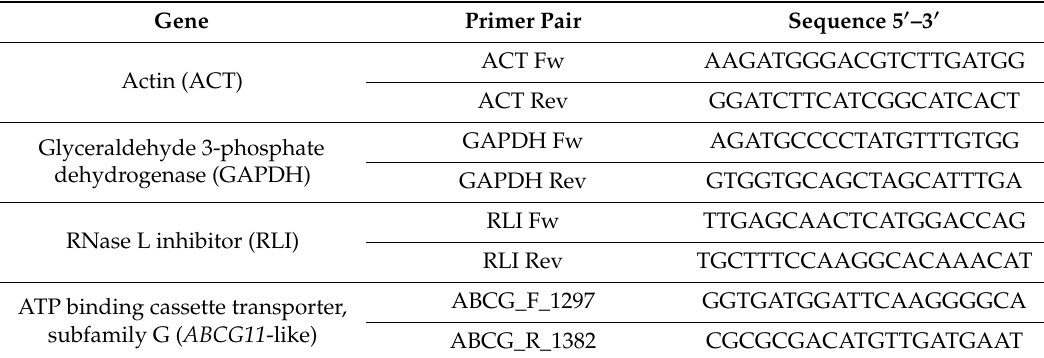
Table 5. Primers used in qPCR for amplification of reference genes and studied gene ScABCG11 . Gene Primer Pair Sequence 5 (cid:48) –3